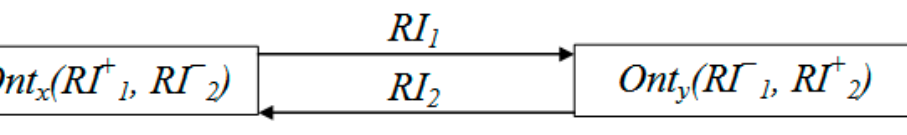
Figure 4. Common extensive development of ontology.